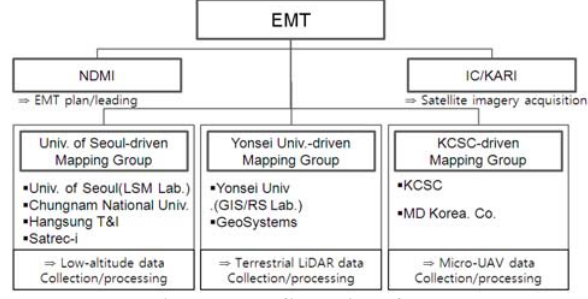
Figure 2. Configuration of EMT